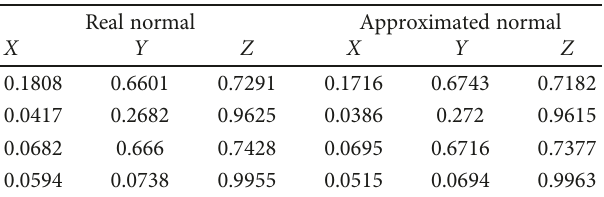
targets. Comparing two 0 noise is 0